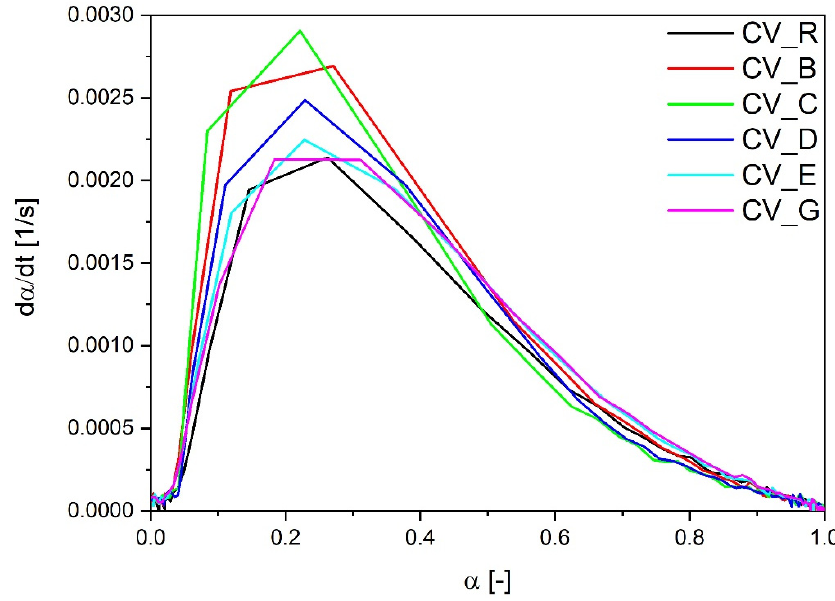
Figure 2. Vulcanization speed as a function of vulcanization degree for rubber compounds prepared in the CV system. CV_...—rubber compounds containing n-ZnO in a conventional curing system; CV_R—reference rubber compound containing standard ZnO in a conventional curing system.